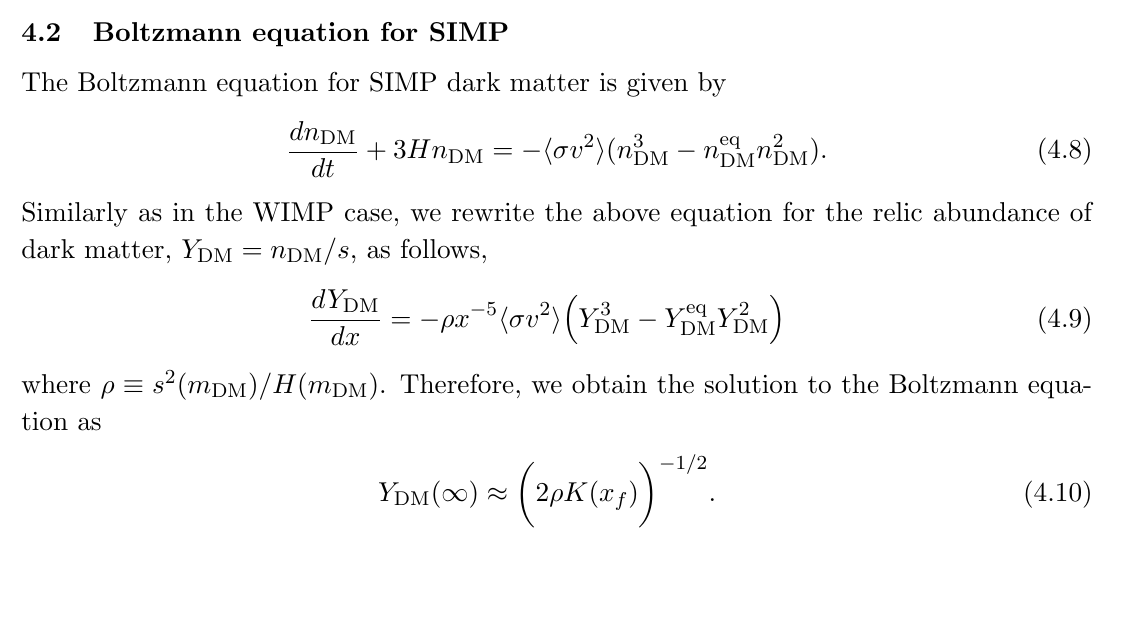
Figure 3 . J -factors on vs o(cid:11)-resonance for WIMP. Narrow Width Approximation(NWA) for the resonance is assumed and (cid:13) R ; (cid:15) R are related to the resonance width and the amount of o(cid:11)-resonance as de(cid:12)ned below eq.